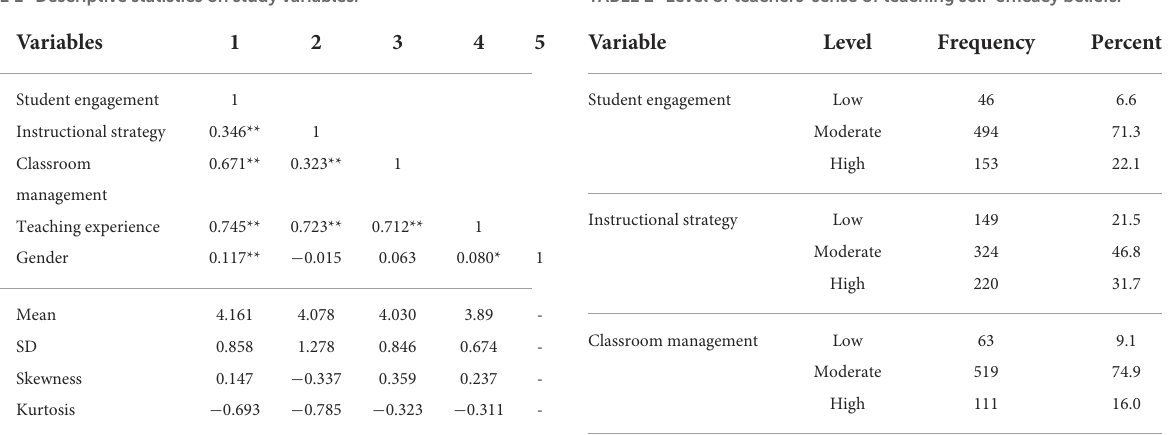
TABLE 1 Descriptive statistics on study variables. TABLE 2 Level of teachers’ sense of teaching self-efficacy beliefs.